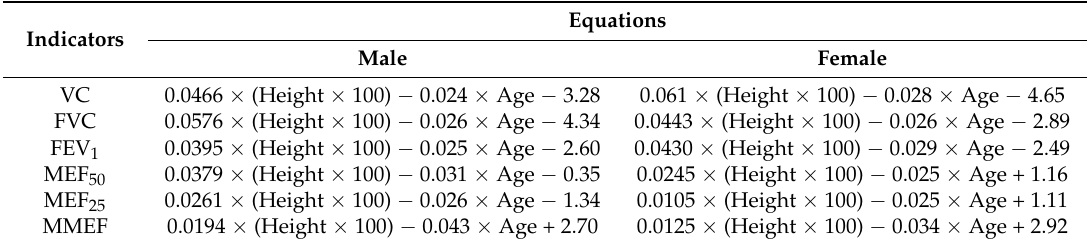
Table A1. Equation of calculating individual predicted value of lung function indicators developed by European Respiratory Society (ERS) in 1993.